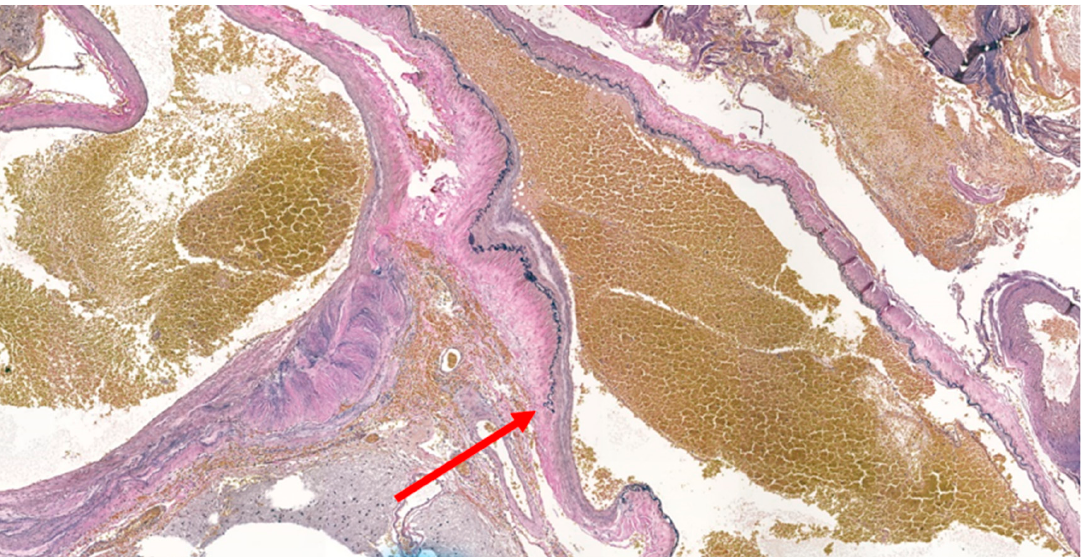
Figure 8. Verhoeff–Van Gieson stain for arteriovenous malformation. Staining showed discontinuity of the elastic fibers, which revealed ambiguous vessels exhibiting characteristics of both arteries and veins, consistent with an arteriovenous malformation (red arrow).